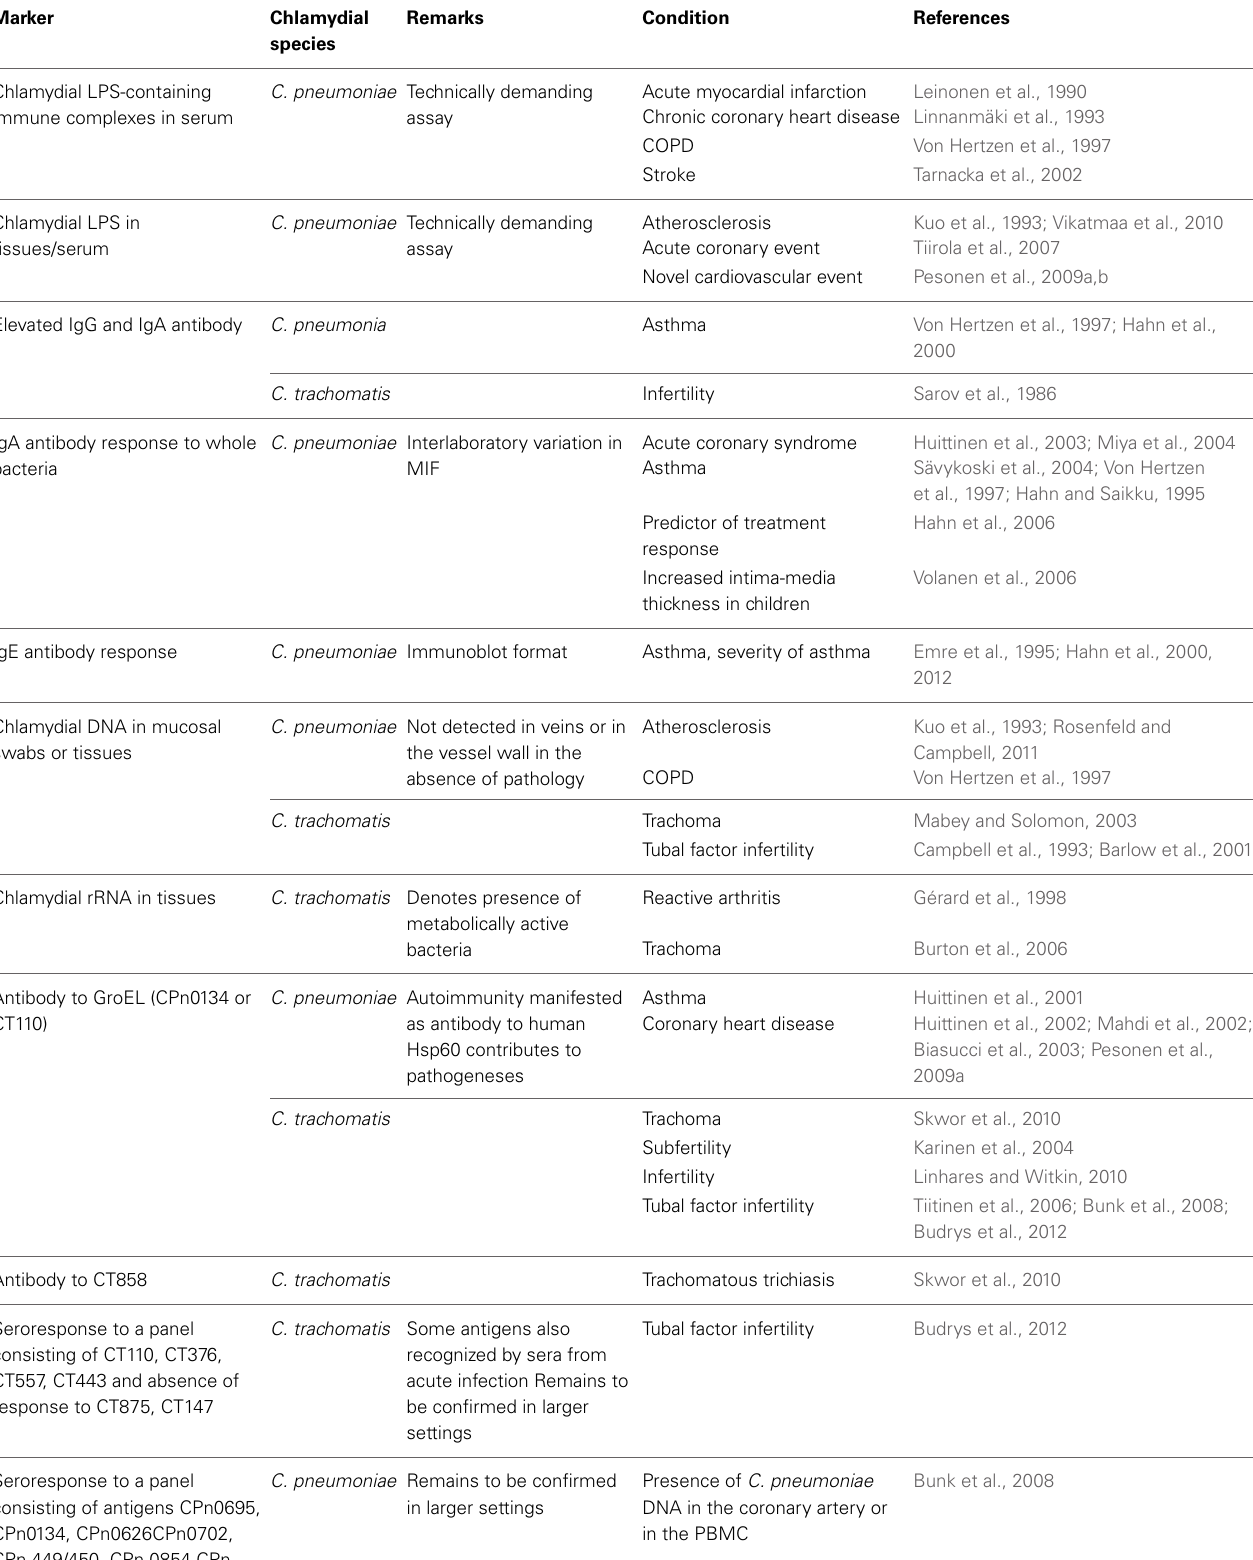
Table 1 | Potential biomarkers of persistent human chlamydial